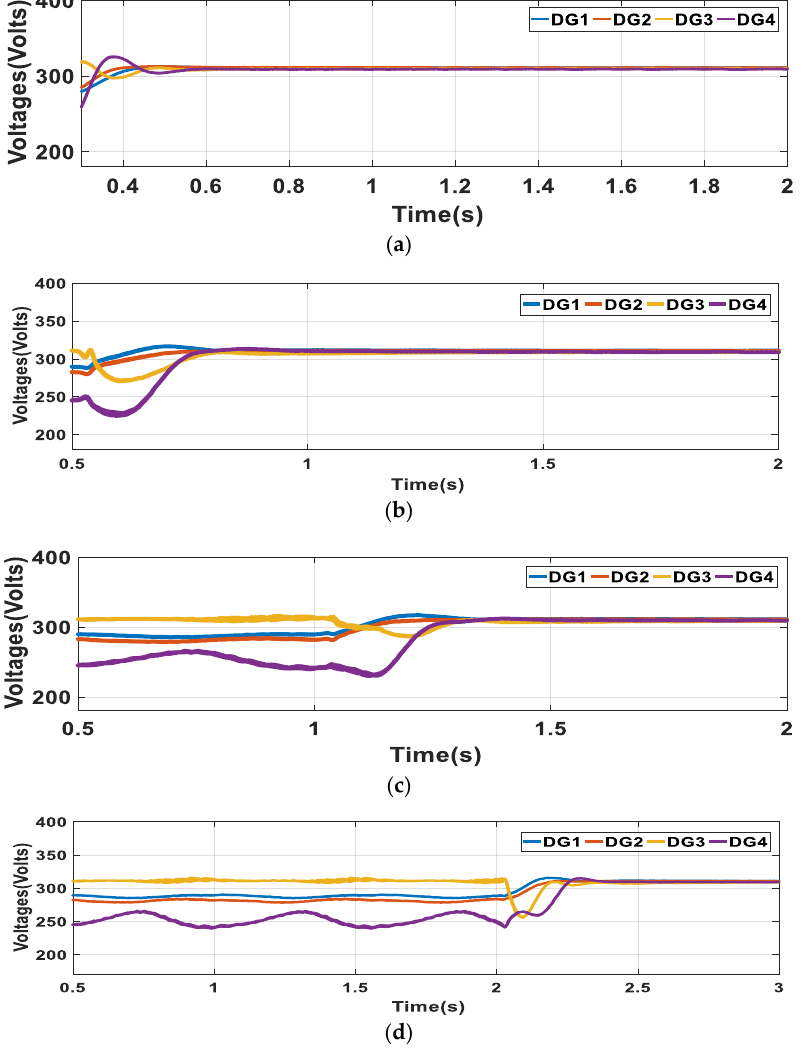
Figure 13. Output results of 4 DGs for voltage restoration with time delays ( a ) 0.1 s; ( b ) 0.5 s; ( c ) 1 s and ( d ) 2 s as in case 3.